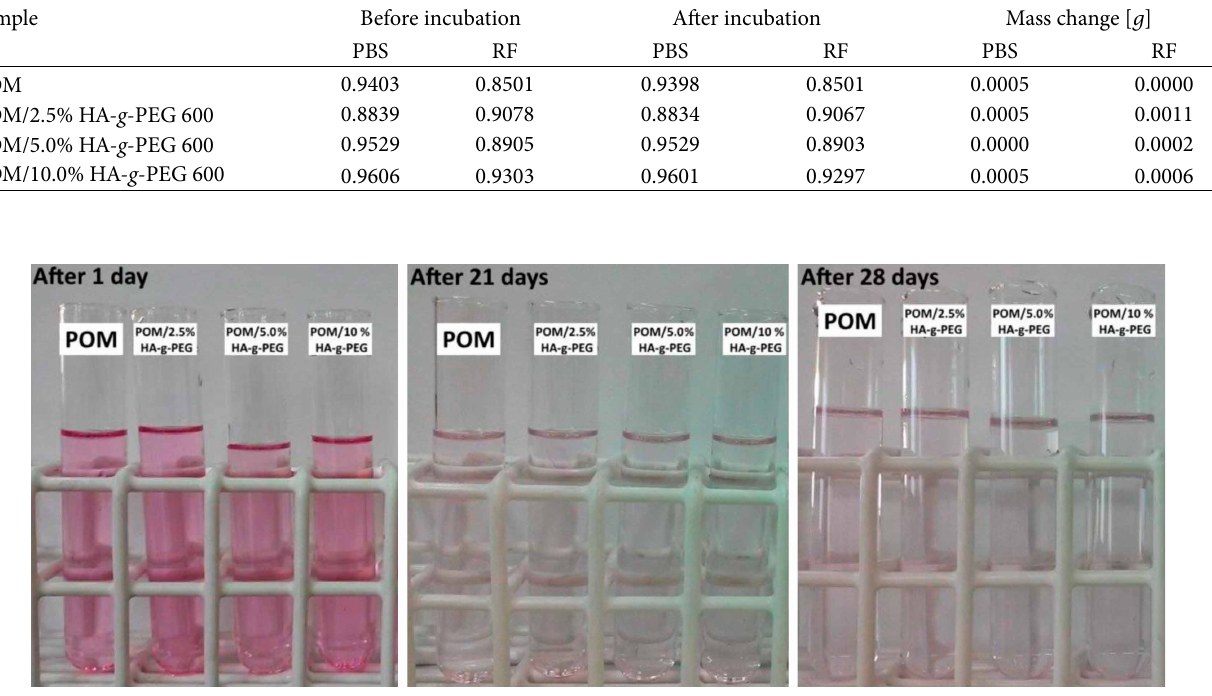
Table 6: The mass of POM and POM/HA- g -PEG 600 samples before and after incubation in PBS and RF. Sample